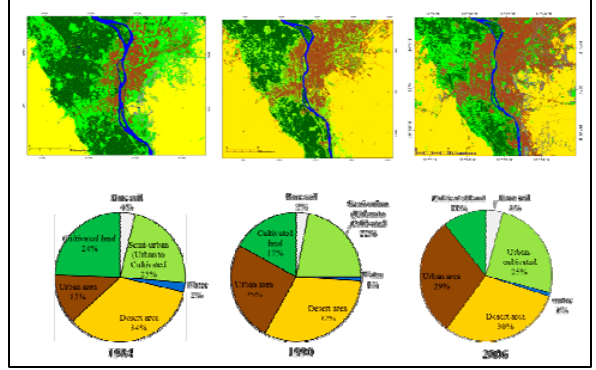
Figure 2. Change detection in study area Table 1: Percentage of LU / LC classes in the study